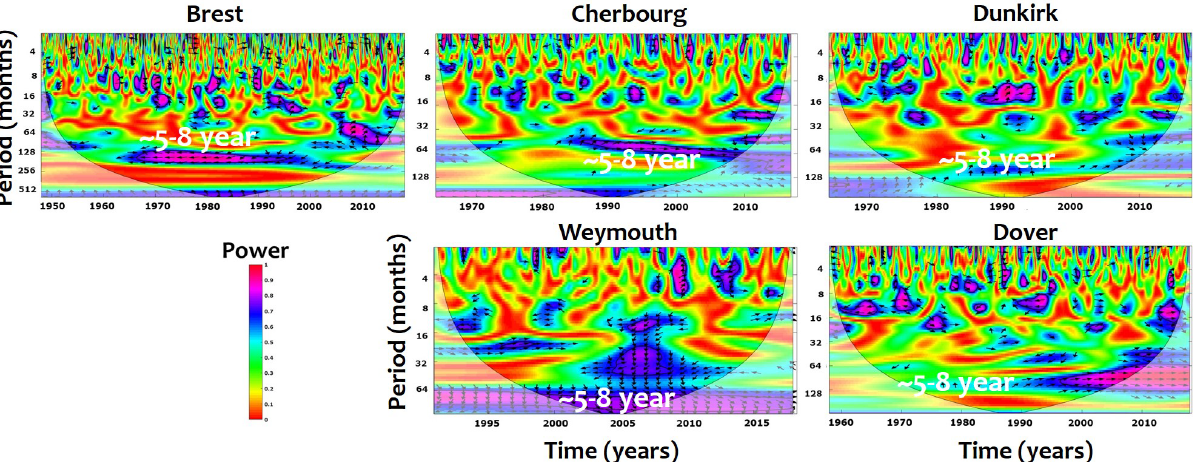
Figure 7. Cross-wavelet correlations between monthly extrema of surges and the North Atlantic Oscillation (NAO).